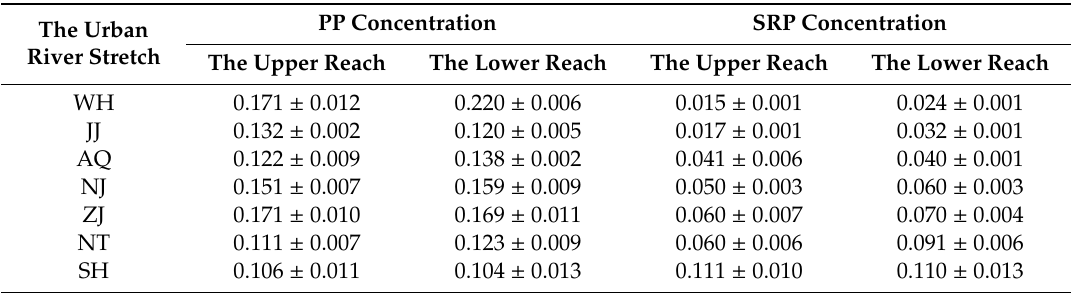
Table 2. The PP and SRP concentrations from the upper reaches and the lower reaches of the urban river stretches along the middle and lower reaches of the Yangtze River (mg / L).